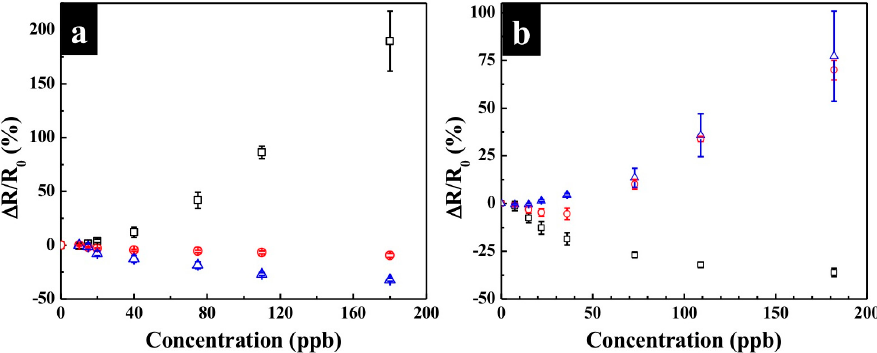
Figure 3. ( a ) Effect of humidity on the detection of O 3 by KI-PANI device at 25 °C and 10% RH (black/ □ ), 35% RH (red/ ○ ), and 50% RH (blue/ ∆ ); ( b ) Effect of temperature on the detection of O 3 by KI-PANI device at 50% RH and 25 °C (black/ □ ), 35 °C (red/ ○ ), and 50 °C (blue/ ∆ ). Data points are average of responses from three or more independent sensors, and error bars represent ±1 standard deviation.